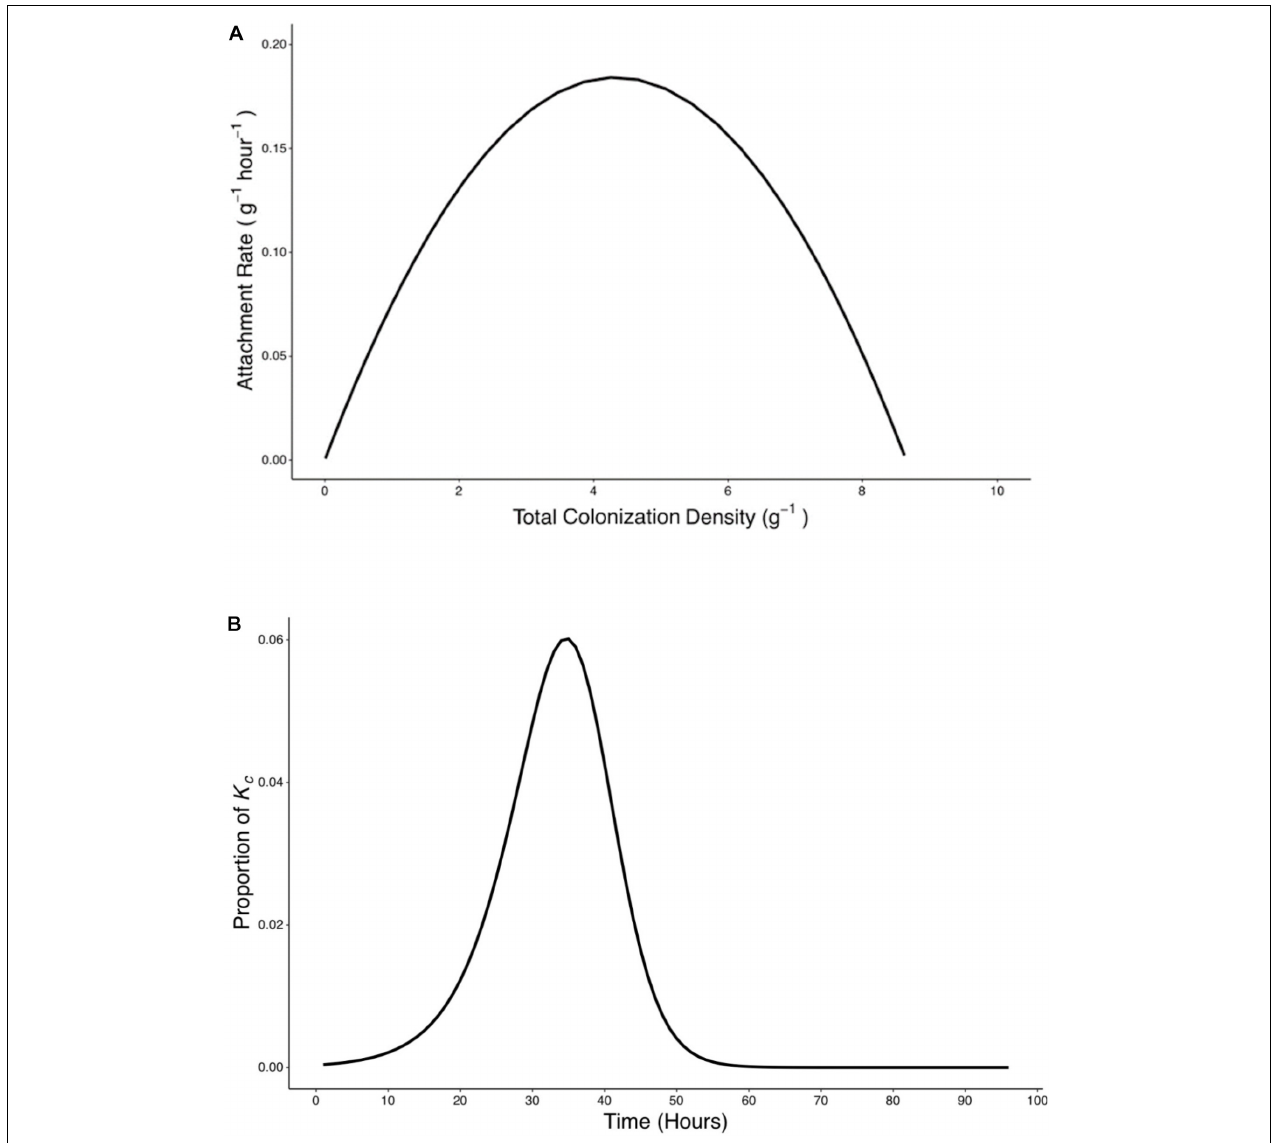
FIGURE 7 | Rate of attachment ( R a ) expressed as a function of total colonization density ( y c ) and the relative contribution of attachment to final colonization density was established. (A) The relationship between rate of attachment and total colonization rate can be expressed as a quadratic